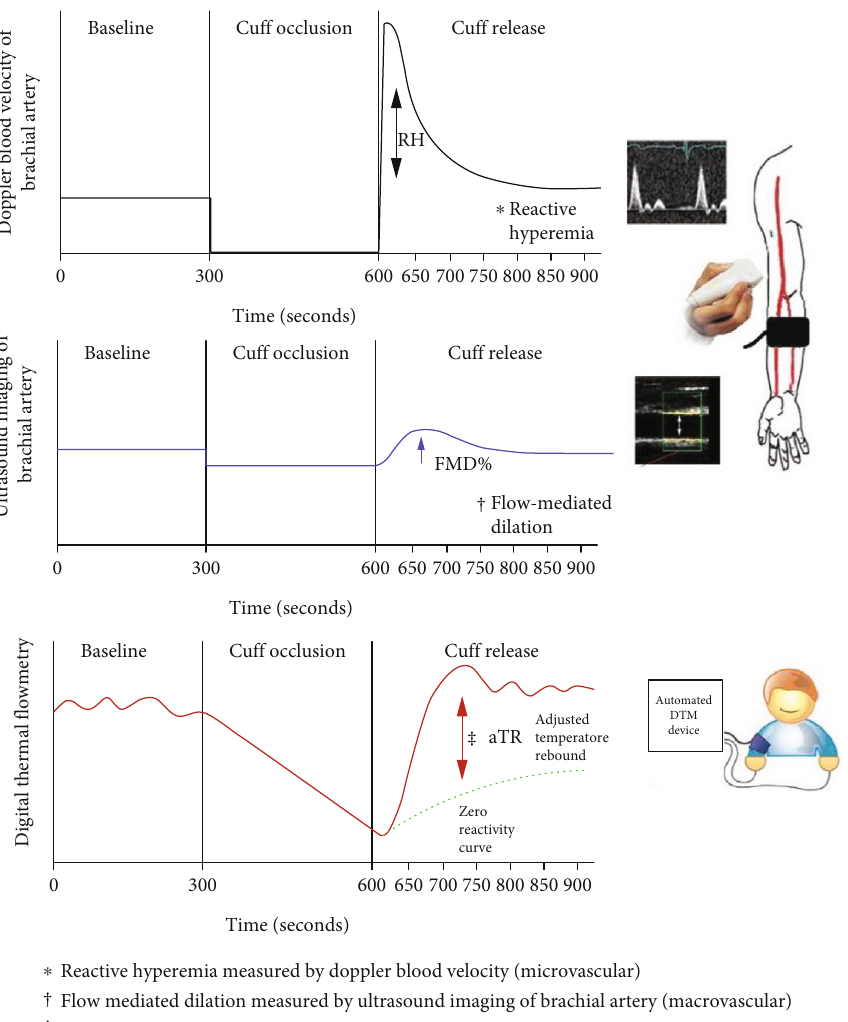
Figure 1: Comparisons between reactive hyperemia (RH) and fl ow-mediated dilation (FMD) measured by ultrasound imaging versus digital thermal monitoring